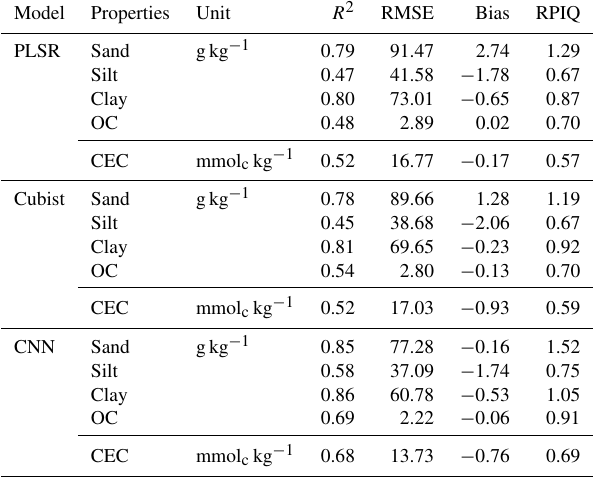
Table 3. Results of model validation for the prediction of various soil attributes using the full calibration data